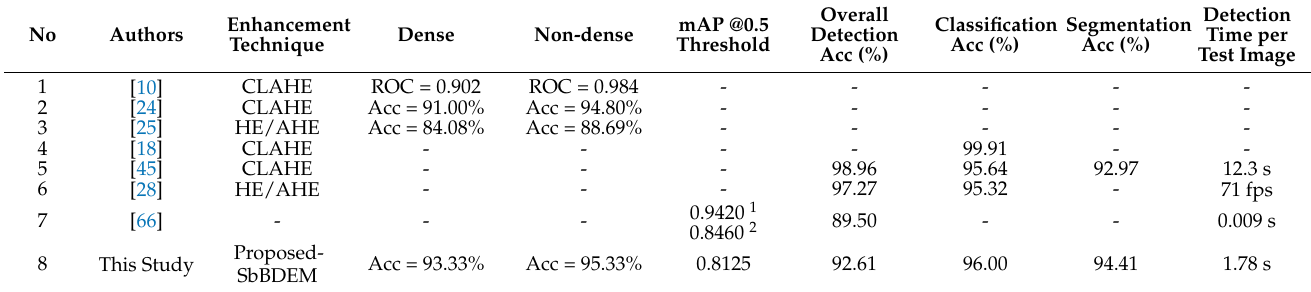
Table 4. Comparison of CAD for mammogram mass detection previous